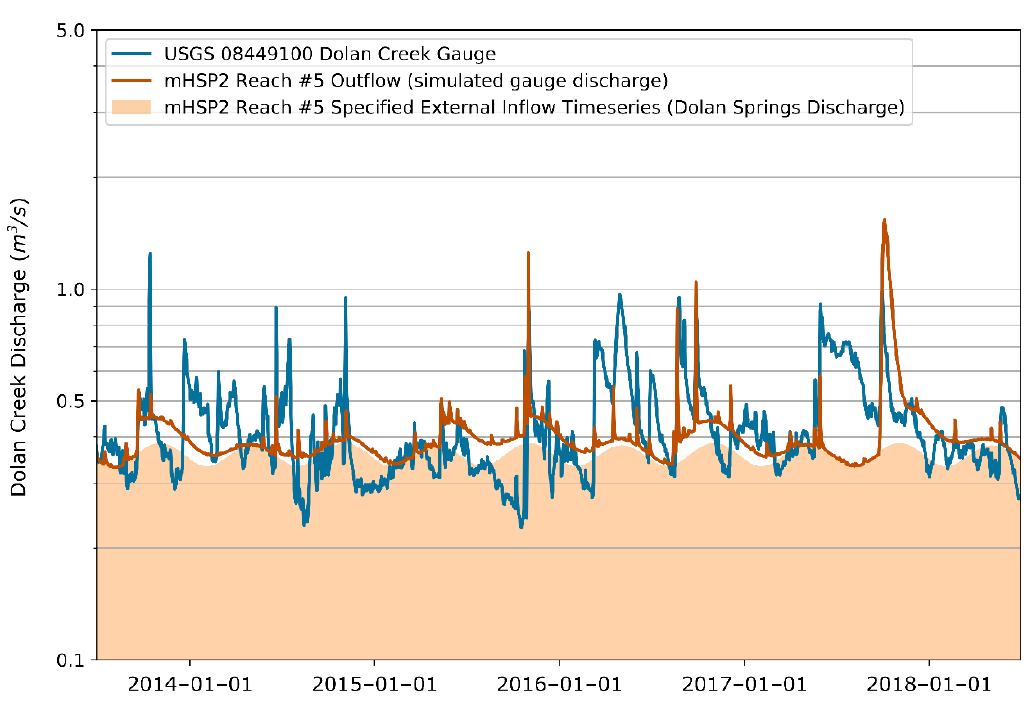
Figure A4. mHSP2 model calibration results. Daily measured discharge at USGS Gage 08449100 provides the calibration targets. Spring discharge to Reach #5 enters the HSPF model as an external inflow time series. Overall, the match between simulated and observed is adequate. In time intervals where the peaks and/or valleys are not captured correctly, the working assumption is that the 25th percentile day of year discharge values do not appropriately represent spring discharge.